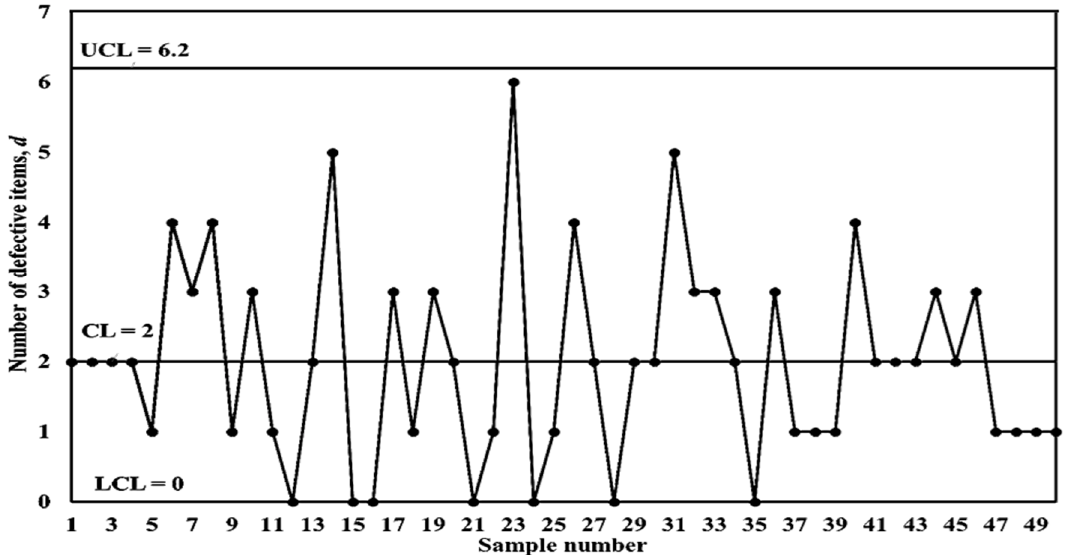
Figure 4. The standard np with three-sigma control limits .